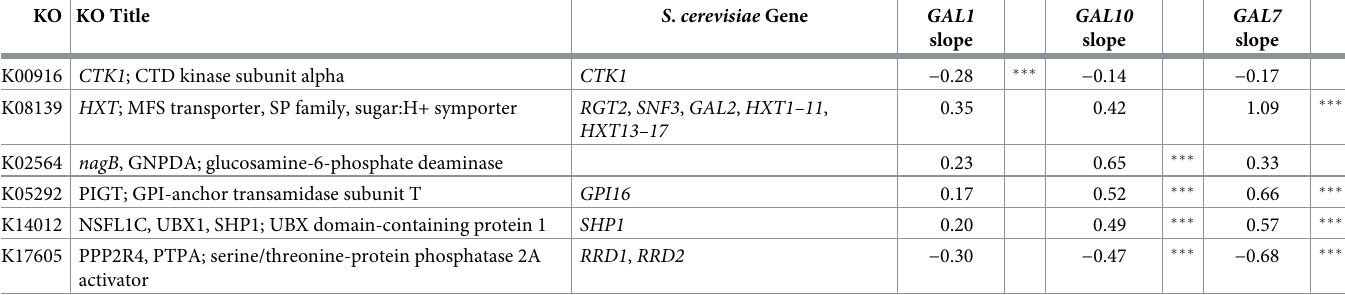
Table 1. KEGG Orthology (KO) annotated genes that have a codon optimization correlated with GAL1 , GAL10 , or GAL7 . This table contains the significant (multiple test corrected p -value < 0.001 ��� ) results with the greatest absolute slope for each GAL gene and 3 additional results that are significant in both GAL7 and GAL10 . Gene names for S . cerevisiae are listed where